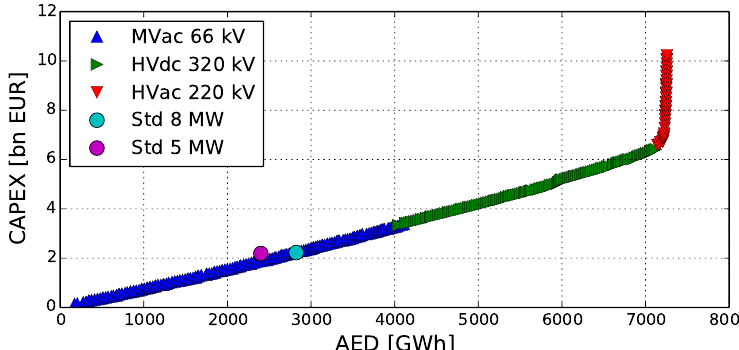
Figure 16. Optimized trade-off obtained between the optimization goals for areas I and II and standard layouts. The optimized layouts will be numbered from left to right, i.e. , with increasing annual energy delivered (AED) and